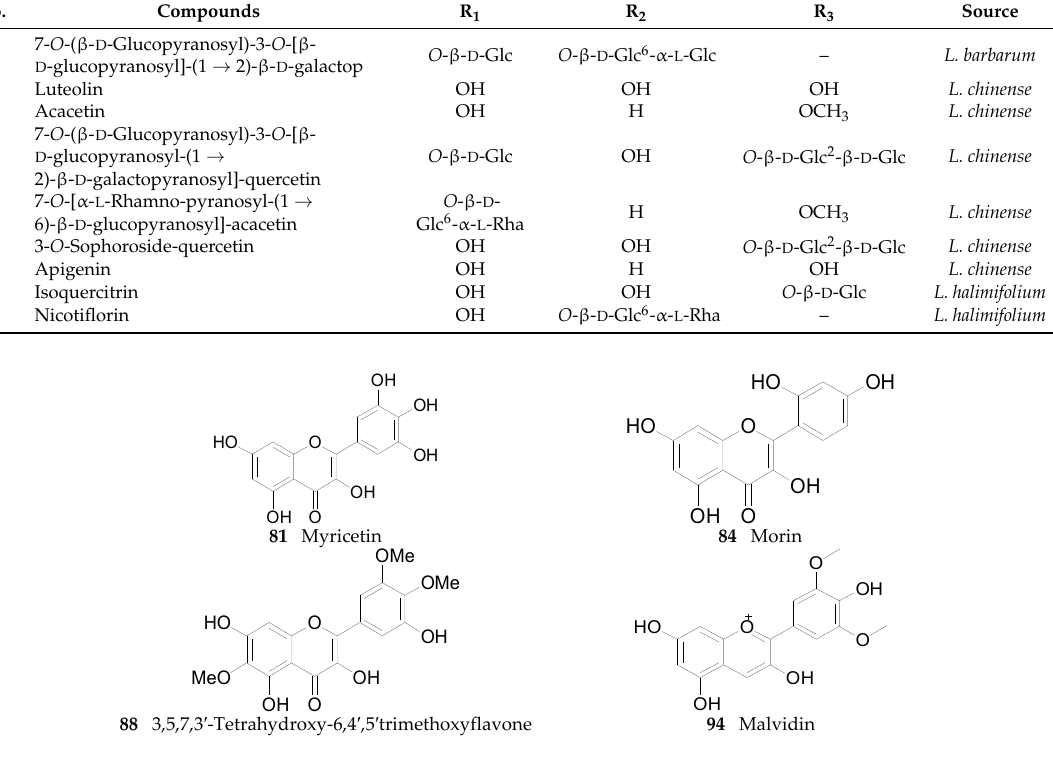
Figure 6. Chemical structures of compounds 81 , 84 , 88 and 94 . Table 8. Chemical structures of compounds 95 – 98 .